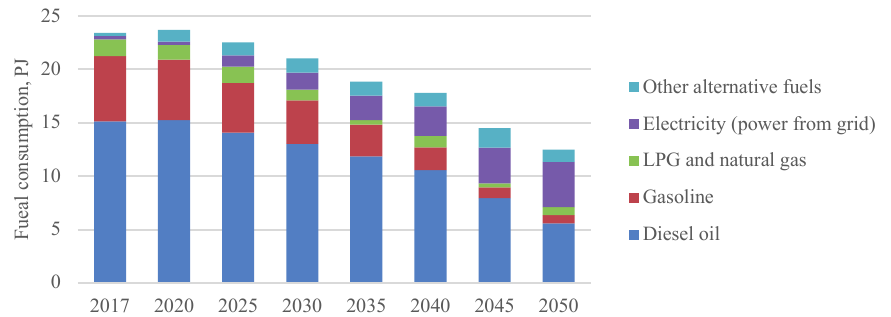
Fig. 11. Fuel consumption for land passenger transportation in GHG TARGET scenario. The sensitivity analysis was done by increasing the prices of fossil fuels e.g. diesel oil, gasoline, LPG and natural gas for the NECP scenario. Starting from 2025 it is assumed that the prices for these resources will be two times higher than in the base year, followed by a 5 % increase each year until the end of the modelling period (scenario NECP+).